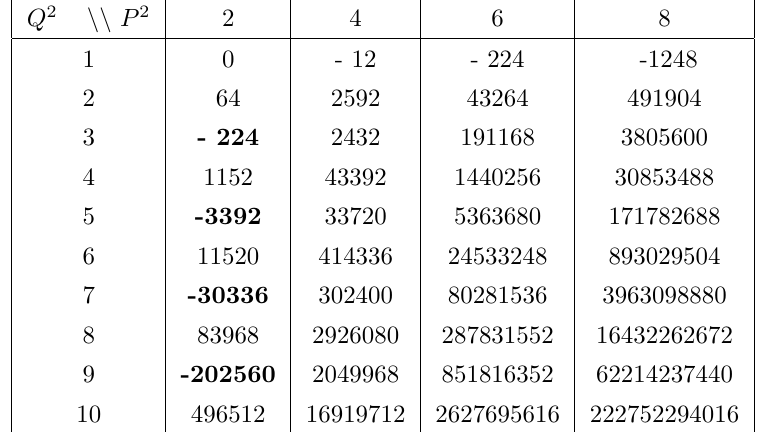
Table 18 . The index d ( Q, P ) for the Z 2 toroidal orbifold some low lying values of Q 2 , P 2 with Q · P = 2 .